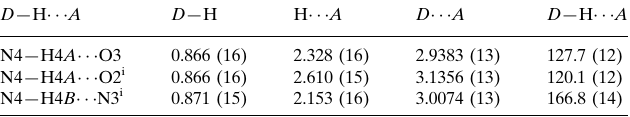
Hydrogen-bond geometry (A˚ , (cid:1)